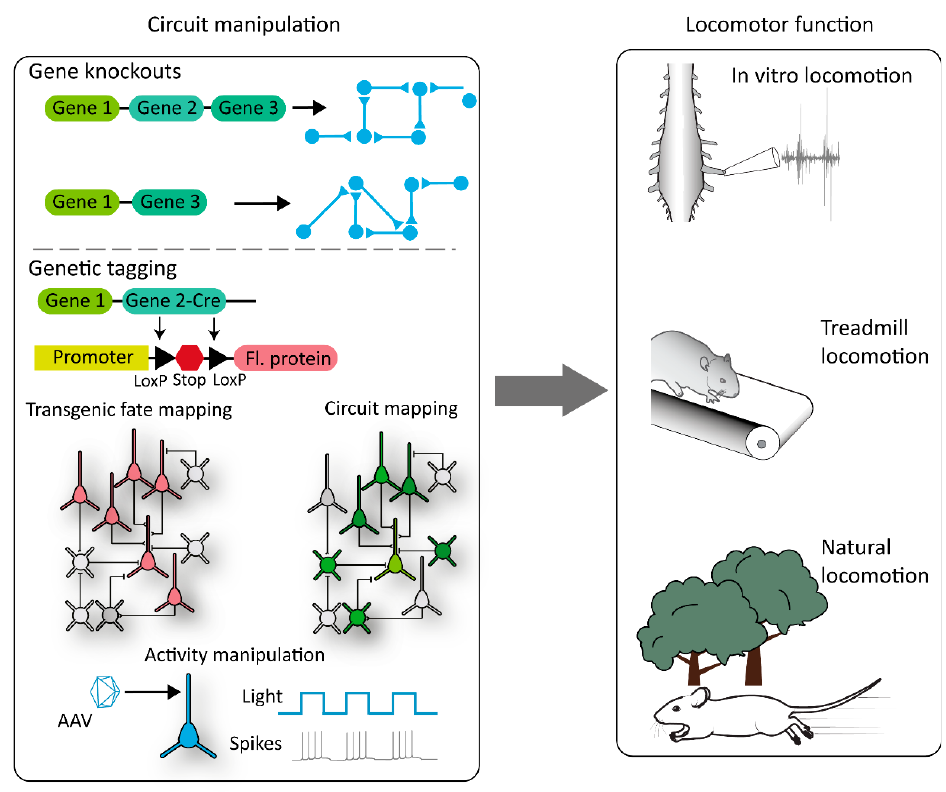
Figure 2. Summary of the molecular genetic strategies that can be used to dissect the locomotor circuitry. Gene knockouts (top line) can lead to circuit rearrangements that can be combined with several techniques to analyze the function of that circuit (right). Similarly, gene expression can be used to tag populations of neurons and probe their functions via manipulations of their activity or by tracing their synaptic inputs. Fl. protein = fluorescent protein.